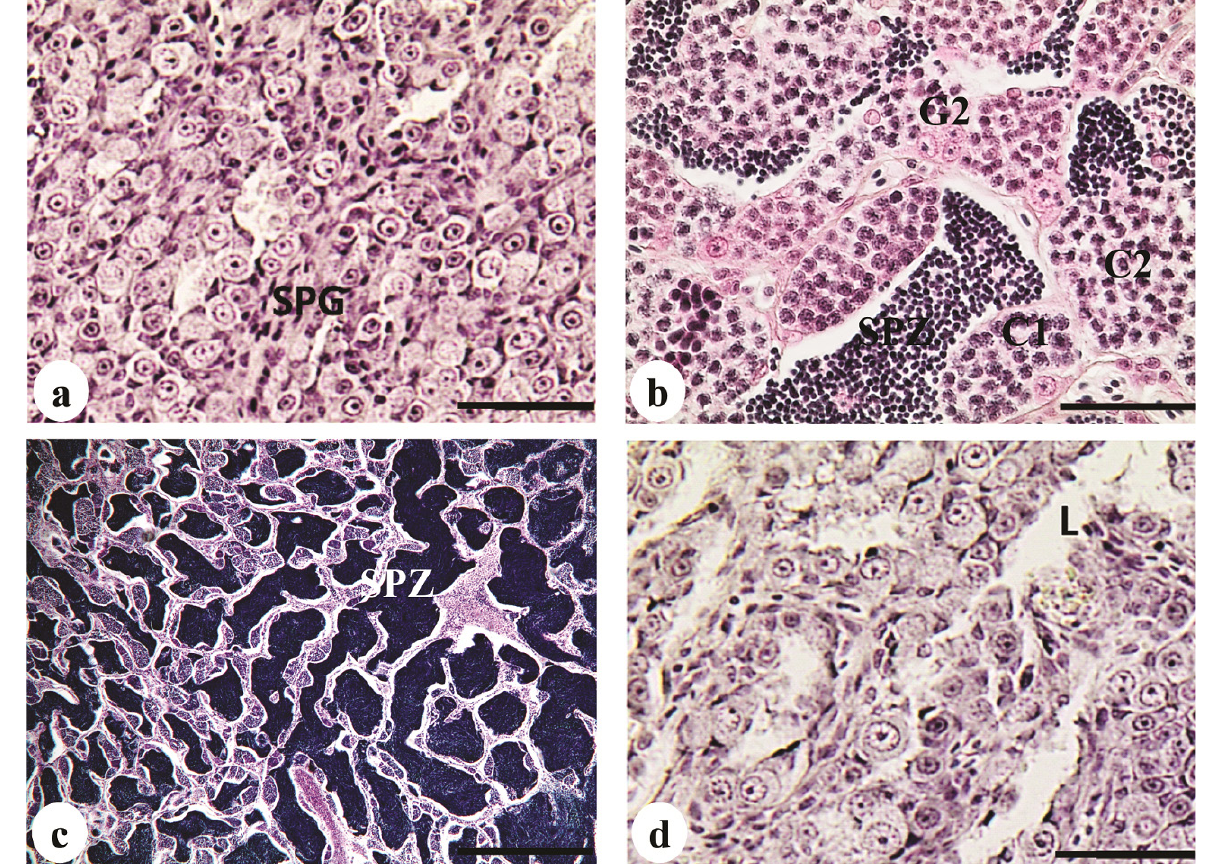
Figure 3. The histological sections of the testes of S. elegans are shown in different stages of the gonadal maturation stained by HE. a) Stage M1 = rest containing only spermatogonia (SPG) and lumen of the closed seminiferous tubules. b) The cells of the spermatogenic lineage are shown with primary spermatogonia (G1, diameter = 6.18 ± 1.01 µm). An abundant cytoplasm and a spherical central nucleus are displayed, as well as secondary spermatogonia (G2 = 5.19 ± 0.80 µm) with little cytoplasmic material and a spherical central nucleus. The primary spermatocyte (C1 = 3.95 ± 0.51 µm) is with spherical the central nucleus and granulated chromatin. The secondary spermatocyte (C2 = 2.93 ± 0.54 µm) is with the spherical central nucleus and fine chromatin. The spermatid (T = 1.32 ± 0.17 µm) with the dense spherical nucleus. The spermatozoa (SPZ = 0.95 ± 0.15) presents a spherical head and strongly condensed nucleus. c) Stage M2 = maturation with the lumen of the seminiferous tubules filled with spermatozoa. d) M3 = time spent with the lumen (L) of the seminiferous tubules open and the wall containing only spermatogonia. Bars: a, b, and d = 50 μm. Bar c = 200